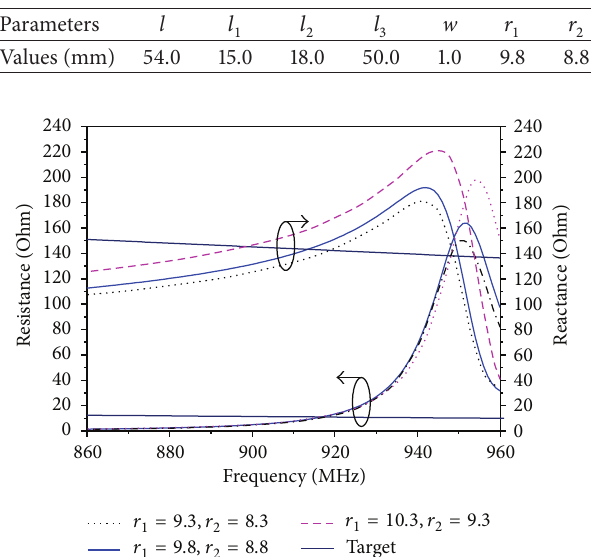
Table 2: Parameter values of optimized antenna.